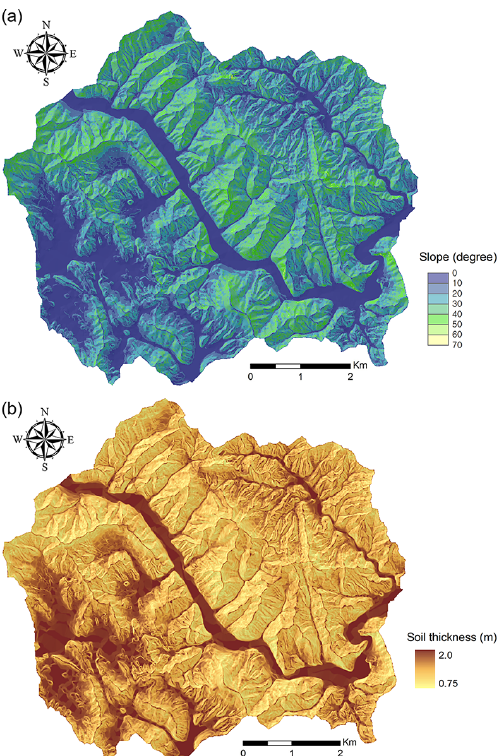
Figure 9. Map showing the distribution of topographic parameters. (a) Slope angle and (b) soil